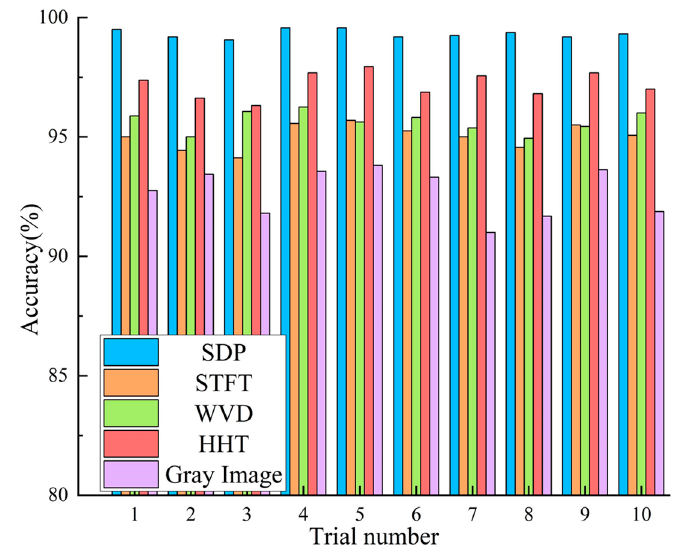
Figure 10. Diagnosis results of the ten experiments with various approaches. Table 5. Experimental results with four different